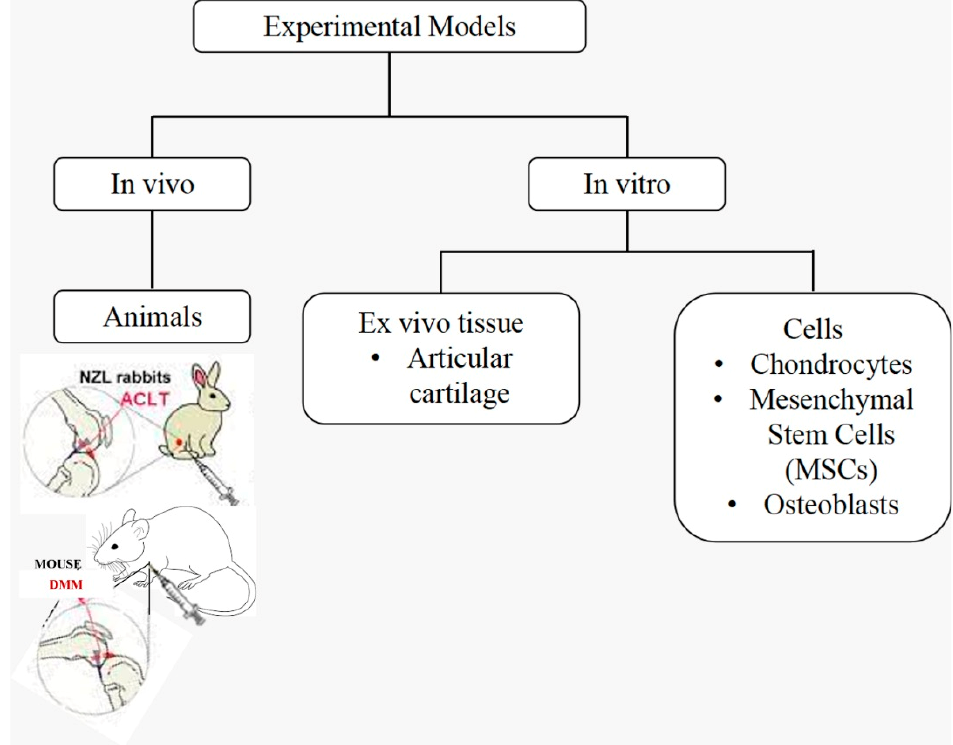
Figure 3. Summary of experimental models addressing OA treatment using hypoxia.